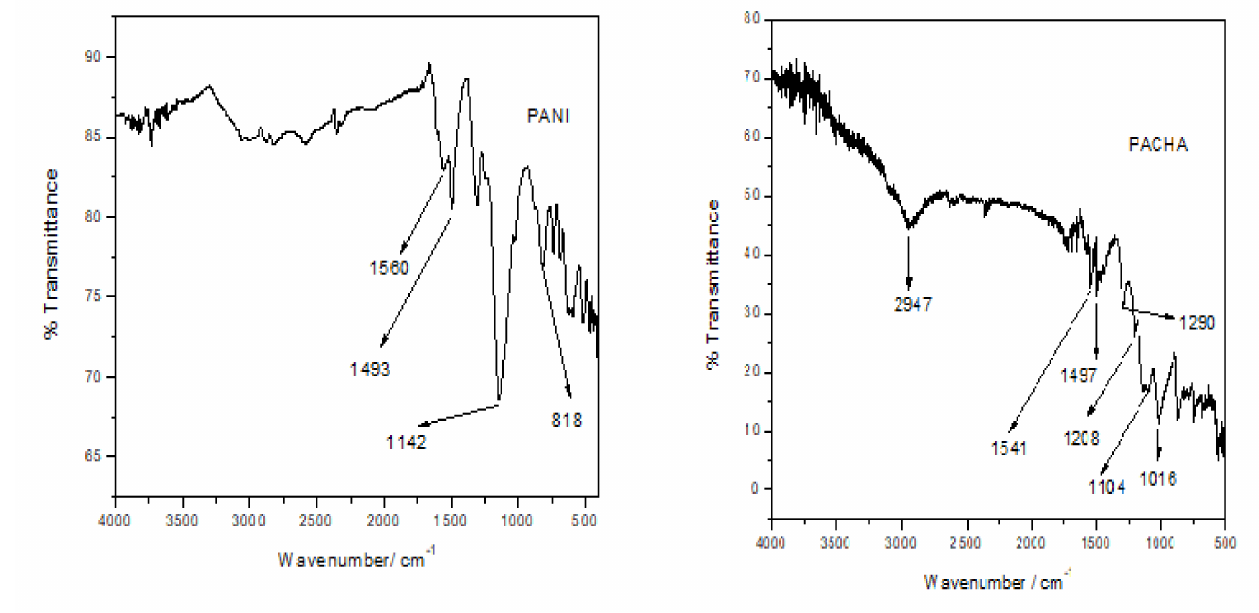
Figure 3. FTIR spectra of PANI and